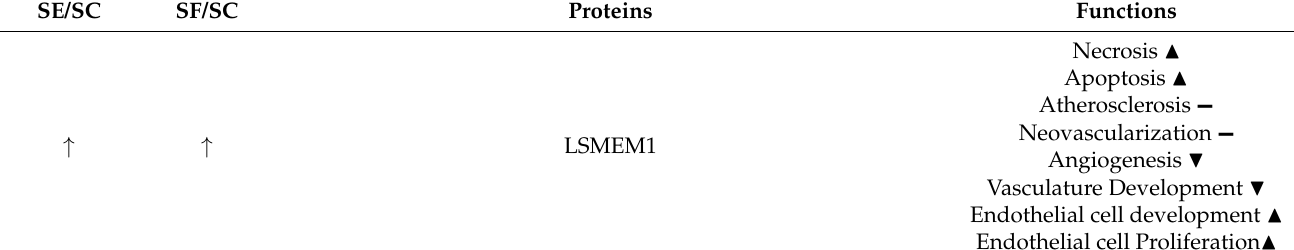
Table 2. Classification of proteins differentially expressed in CACs-treated mice (SE, SF) on day 21. Protein classification was done with IPA, based on the effect of CACs treatment vs. SC levels. The names of protein variations in SE and SF vs. SC on day 21 are shown. Legend: ↑ up-regulated; ↓ down-regulated; (cid:78) predicted activation increased; (cid:72) predicted activation decreased; (cid:150) unknown predicted activation. SE/SC SF/SC